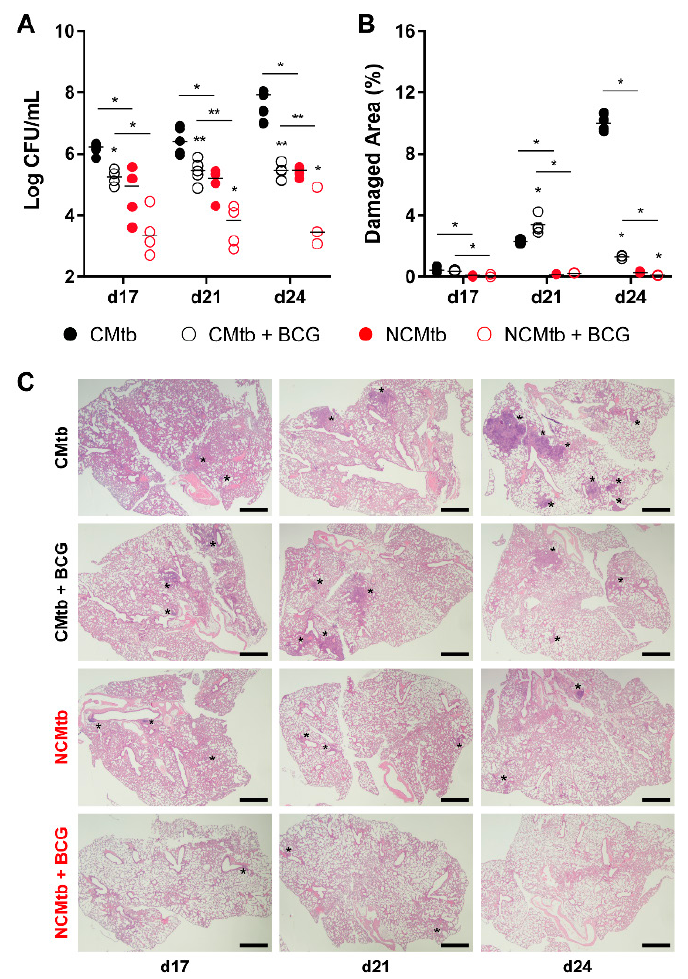
Figure 3. Protective effect of BCG immunization. ( A ) Progression of pulmonary BL, ( B ) lung damaged area and ( C ) evolution of the lesions. Each circle represents an animal ( A ) or a recut ( B ) and lines are medians. Asterisks indicate differences within the same batch; bar and asterisks indicate differences between batches. Mann–Whitney test (* p < 0.05, ** p < 0.01). Scale bars equal 1 mm and asterisks point lung lesions.